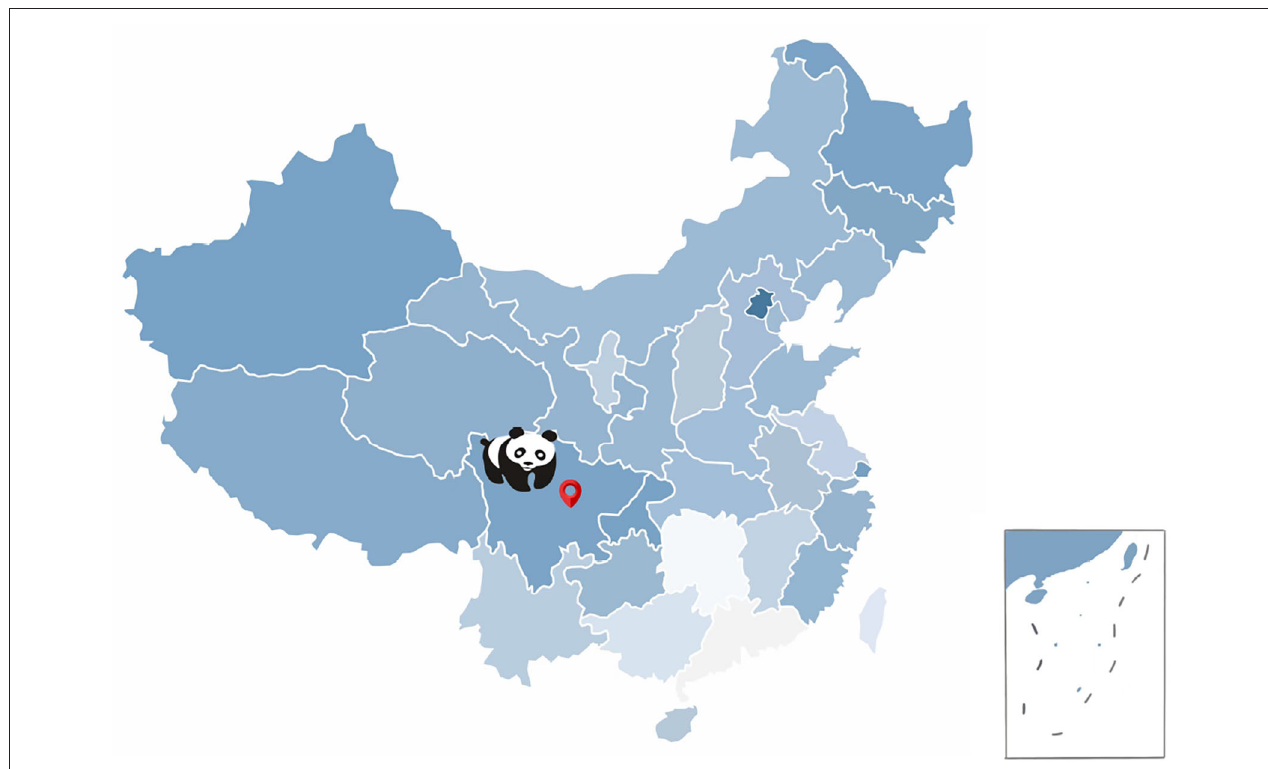
FIGURE 3 | The Chengdu research base of giant panda breeding.